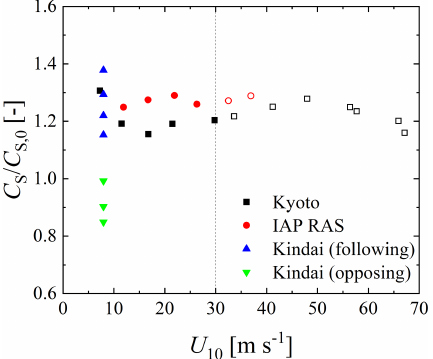
Figure 5. Relationship between the free-stream wind speed and phase velocity C S . The C S is normalized by phase velocity C S , 0 without the Doppler effect, estimated by the dispersion relation of the deepwater waves ( C S , 0 = (gL S / 2 π) 1 / 2 ). Open symbols show the high-wind-speed cases.